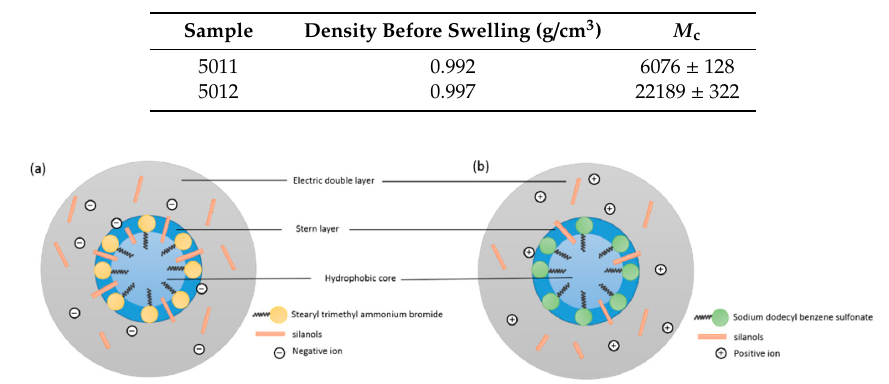
Figure 5. Schematic diagram of crosslinker entering emulsion particle ( a ) coating 5011 ( b ) coating 5012.